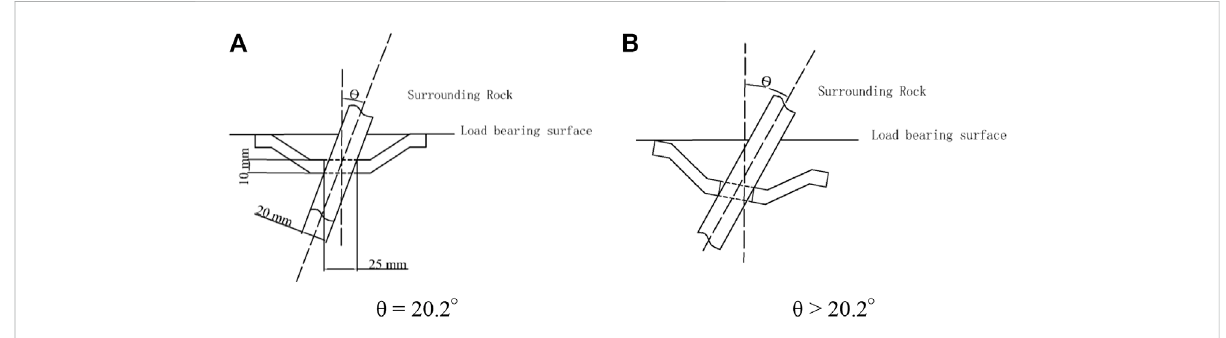
FIGURE 3 Position relation of the pallet and the bolt. (A) θ = 20.2 ° and (B) θ > 20.2 °